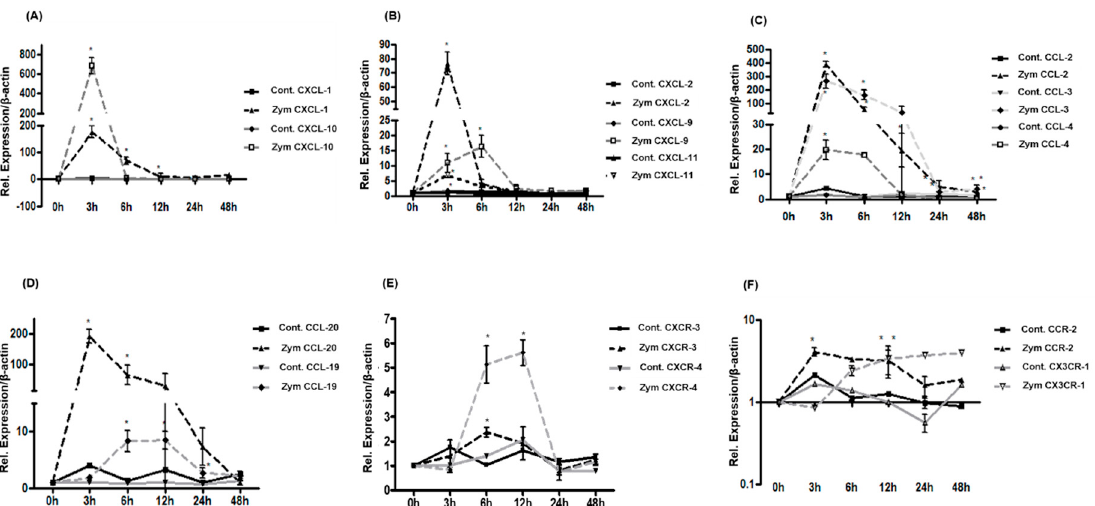
Figure 6. Fold change of mRNA expression of CXC-, CC-chemokines, CC- and CXC-chemokine receptors in intraperitoneally administrated Zymosan rat livers at different time points relative to controls. ( A , B ) Maximum increase of CXCL-1, CXCL-2, CXCL-10 and CXCL-11 gene expression is detected at 3 h by RT-PCR, whereas the maximum gene expression of CXCL-9 is detected at 6 h. ( C , D ) Maximum increase of CCL-2, CCL-3, CCL-4 and CCL-20 gene expression is detected at 3 h by RT-PCR and only CCL-19 gene expression increased significantly at 6 h. ( E ) CXCR-3 gene expression significantly increased at 6 h by RT-PCR whereas CXCR-4 showed a significant increase already at 12 h. The results were normalized to the housekeeping gene β -actin and experimental errors are shown as ± SEM values of six experiments (in duplicate) compared with controls for each time point (* p < 0.05, analyzed by one-way ANOVA). ( F ) CCR-2 gene expression significantly increased at 6 h by RT-PCR whereas CX3CR-1 showed no significant increase. The results were normalized to the housekeeping gene β -actin and experimental errors are shown as ± SEM values of six experiments (in duplicate) compared with controls for each time point (* p < 0.05, analyzed by one-way ANOVA). 2.5. Expression of the Genes of Adhesion Molecules in Rat Livers after GdCl 3 or Zymosan Administration